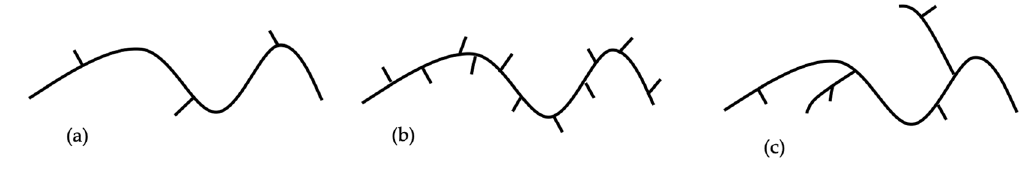
Figure 7. General chemical structure of ( a ) HDPE, ( b ) LLDPE and ( c ) LDPE polymers.